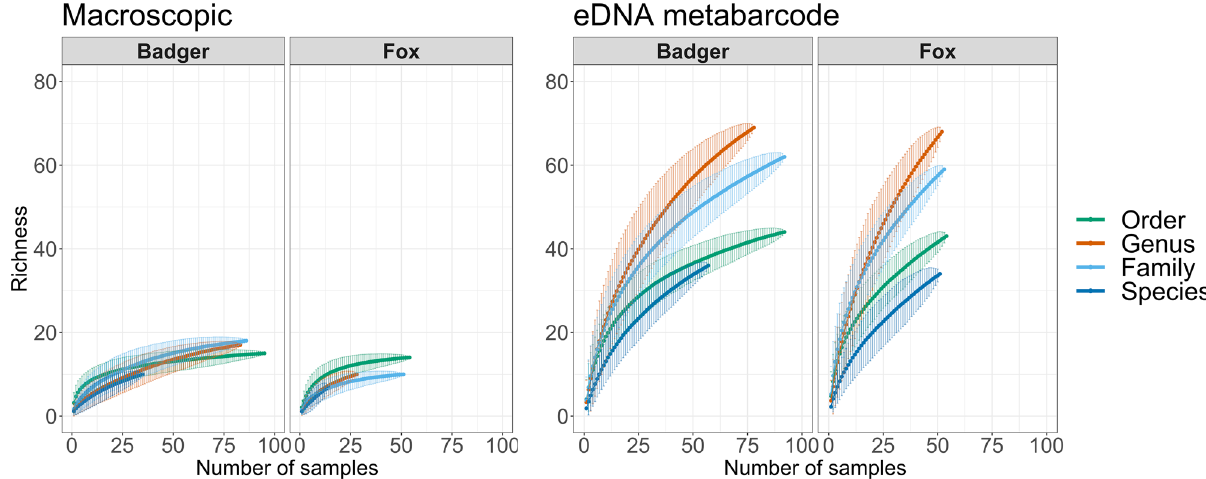
Figure 5. Rarefaction curves (1000 permutations) with Mao Tau values estimating species accumulation at different taxonomic levels for number of taxa in badger and fox separately; left panel = macroscopic diet analysis, right panel = eDNA